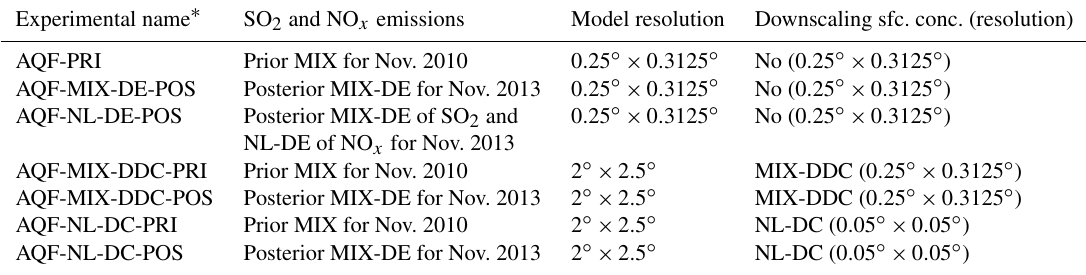
Table 2. Design of experiments for forecasting surface SO 2 , NO 2 , and O 3 concentrations over China in November